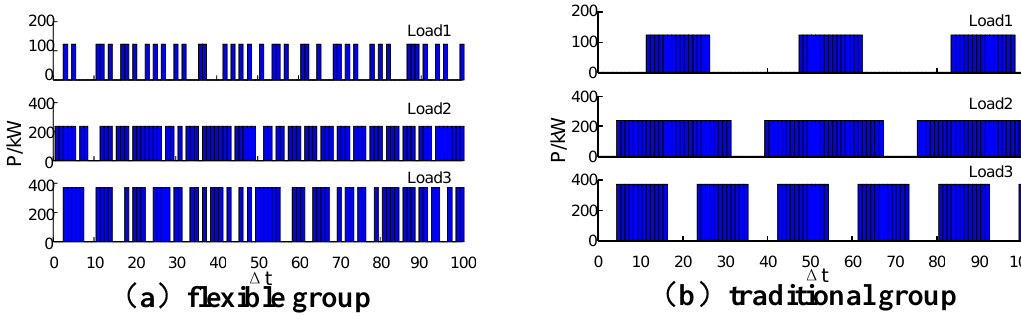
Figure 7. The power consumption comparison of refrigerator loads under normal condition.